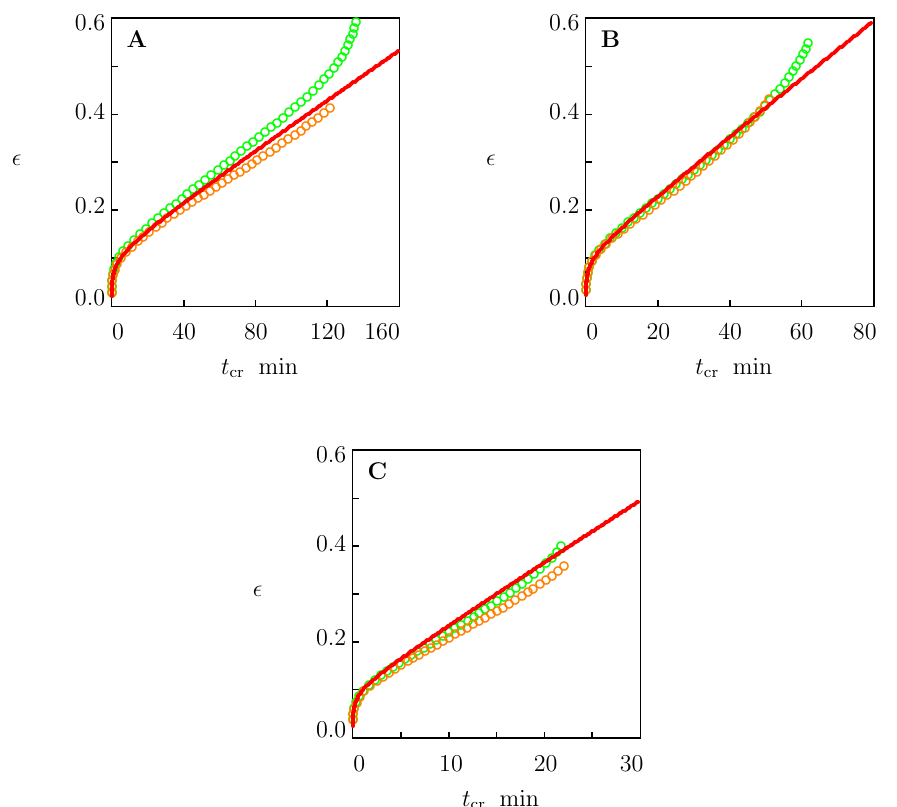
Figure 7. Tensile strain (cid:101) versus creep time t cr . Circles: experimental data in creep tests with tensile stresses σ on two specimens. Solid lines: predictions of the model. ( A )— σ = 18, ( B )— σ = 19, ( C )— σ = 20 MPa.